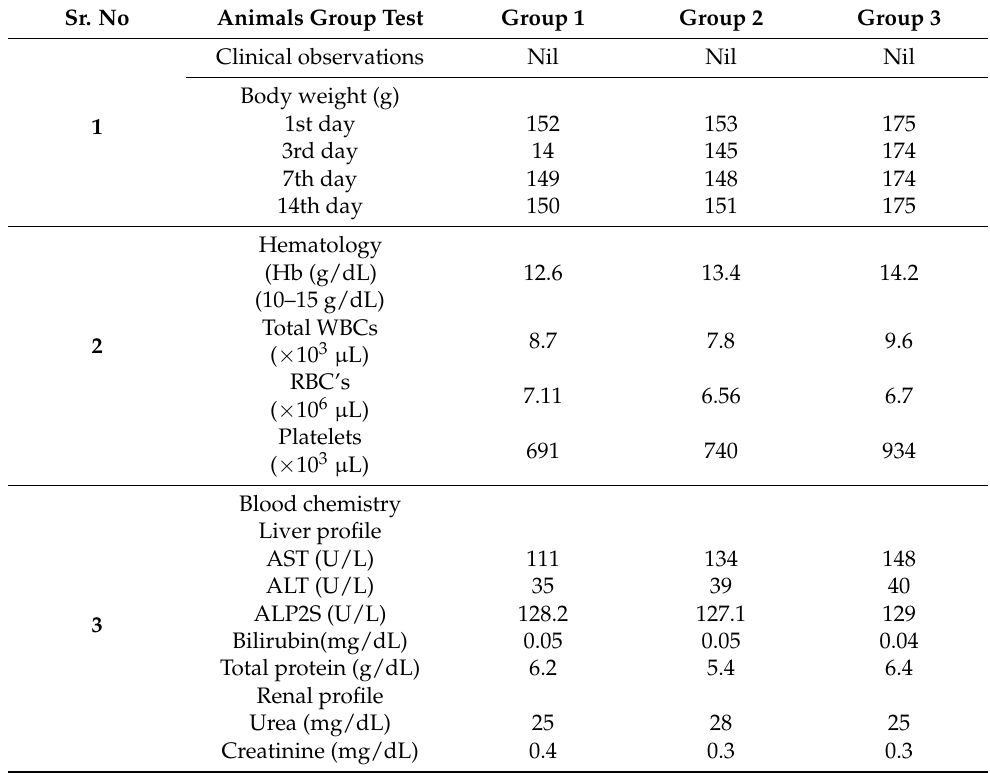
Table 4. Bodyweight, hematology, and blood chemistry of albino rats. Sr.